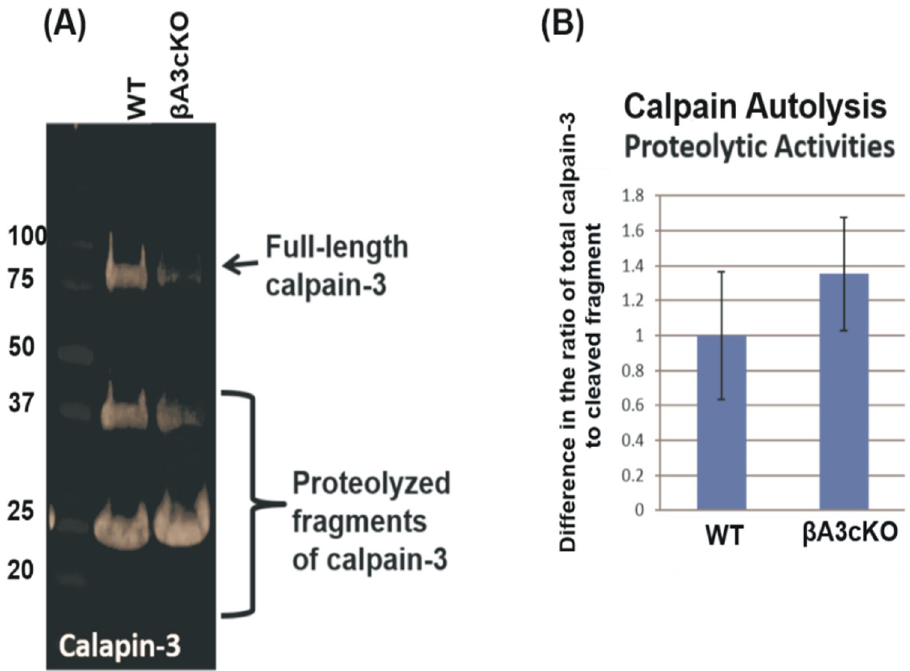
Fig 5. Determination of autolysis of calpain-3 in lens in homogenates of β A3cKO and wild-type lenses by western blot analysis. (A) The Calpain-3 activity was assessed by determining the ratio of total calpain-3 protein (the intensity of full length calpain 3 band + intensity of cleaved fragments) to the amount of uncleaved full-length calpain-3 (intensity of full length calpain-3 band) in homogenates of β A3cKO and wild-type lenses using the western blot analysis. (B) As shown in the Figure, in wild type lenses the ratio of full-length to cleaved fragment was 2.4, whereas in lenses the ratio was decreased to 1.7. This means that relative to wild type lenses, the amount of full-length protein was decreased in β A3cKO lenses, and the amount of cleaved fragment was increased. Overall, the quantification of autolyzed calpain fragments in β A3cKO lenses vs. wild type lenses showed a 35% increase in calpain-3 proteolytic activity in β A3cKO lenses compared to the wild type